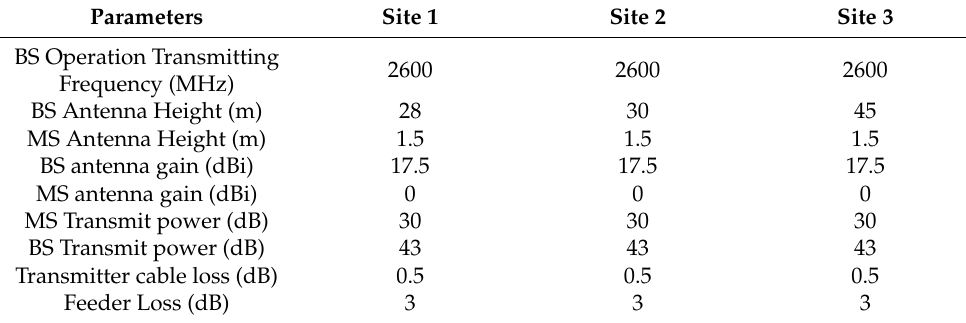
Table 1. Measurement Path Loss Computation